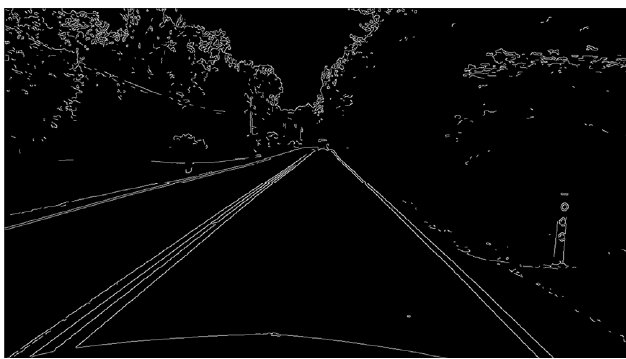
Figure 6. Canny edge detector output image.